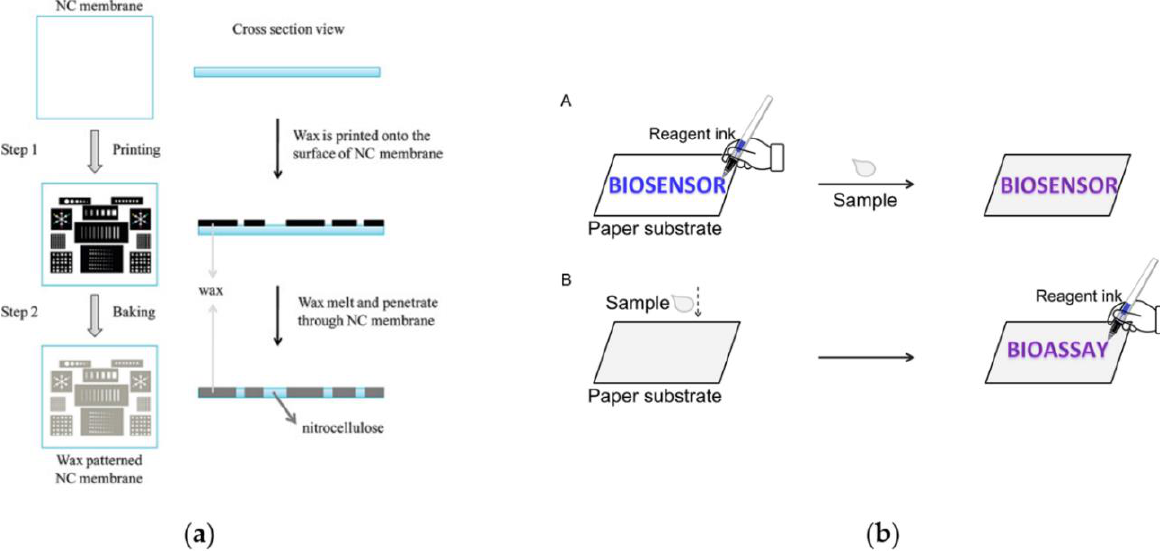
Figure 3. Fluid control and fluid handling: ( a ) schematic illustration of processes to fabricate paper-based microfluidics in an NC membrane by wax printing. It includes mainly two steps: step 1 is to print the wax pattern onto the surface of the NC membrane with a wax printer; step 2 is to bake the wax-printed NC membrane in an oven at 125 ◦ C for 5 min to let the wax melt and penetrate through the membrane fully. Reprinted with permission from [55]. Copyright (2010) American Chemical Society. ( b ) Design of ”pen-writing” technique. (A) When writing biosensors on paper, the sensing elements are directly written to form patterned paper biosensors and would be expected to function at the initial location after introduction of samples leading to the fact that the colored product may not stick in the area where these biomolecules are written. (B) The proposed approach is not dependent on hydrophobic barriers to define the patterning of paper substrates, providing an alternative for sensor fabrication. Paper substrates are directly employed for the collection and transportation of samples, and then the reagent ink pen is used for sample analysis Reprinted with permission from [56]. Copyright 2019 Elsevier..